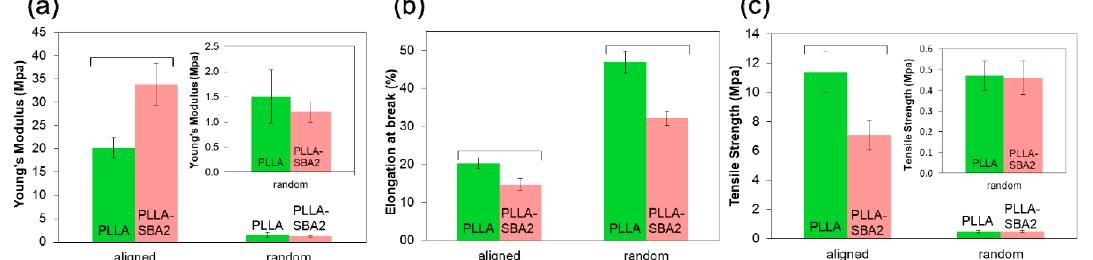
Figure 10. Young’s modulus ( a ), elongation at break ( b ) and tensile strength ( c ) of random and aligned fibers. Results are expressed as (mean ± standard deviation). Bars show statistically significant differences ( p < 0.05). In the inset of ( a , c ) a zoom view of the properties of randomly oriented fibers is reported. Reproduced from [161]. Table 6. Principal properties of electrospinning investigations. With ** tensile (not filled cells mean no data).